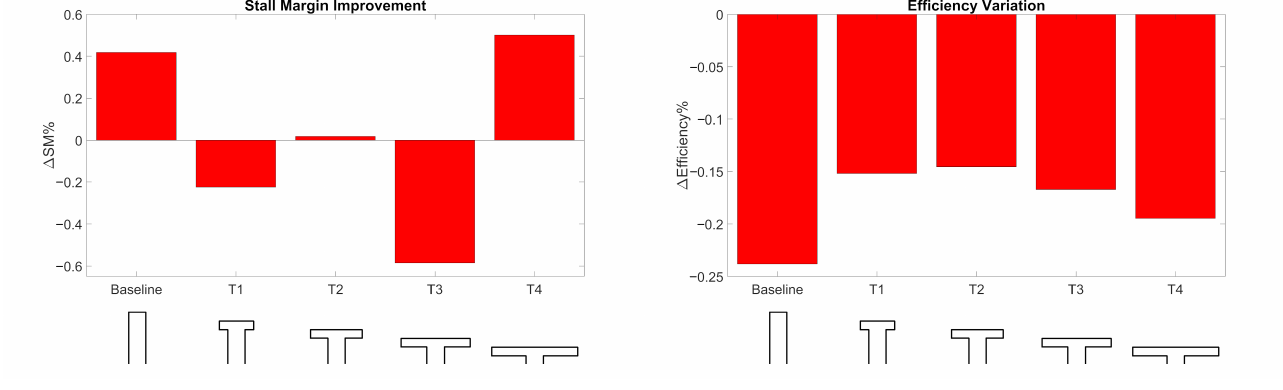
Figure 18. Groove